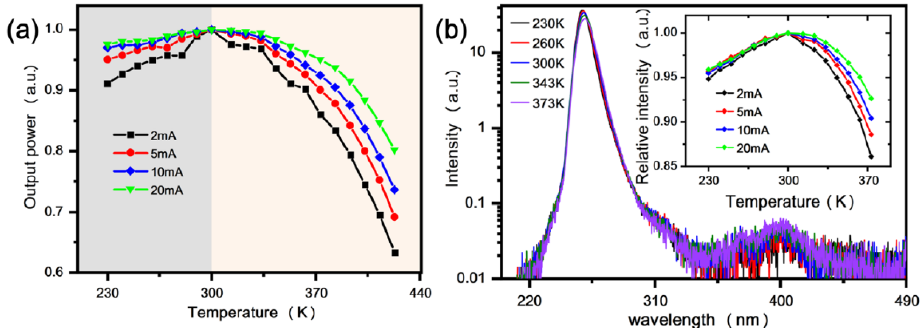
Figure 12. ( a ) Normalized OP of UV-C LED with temperature. ( b ) The EL spectra of LED at different temperatures measured at 2 mA. [56] Copyright 2022, Springer. Finally, we have summarized the operating conditions and related output as given in Table 1. Table 2. Summary of the operating conditions of current stress and related outcomes.